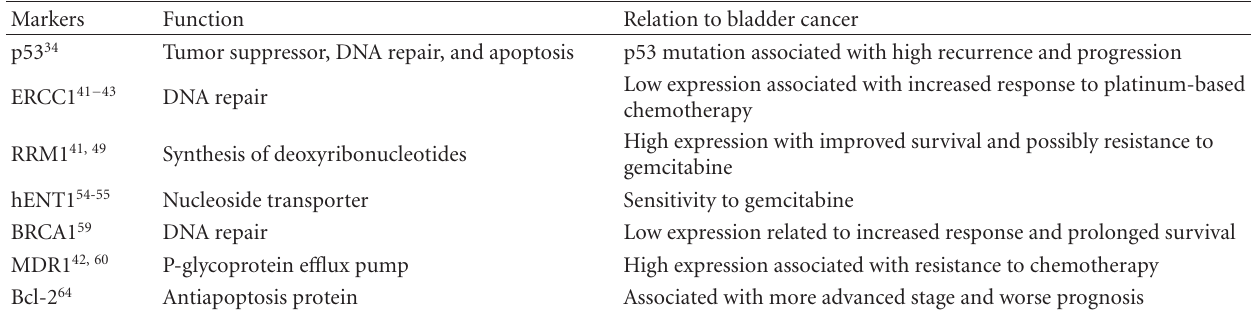
Table 1: Single gene markers for prognosis and prediction of response in bladder